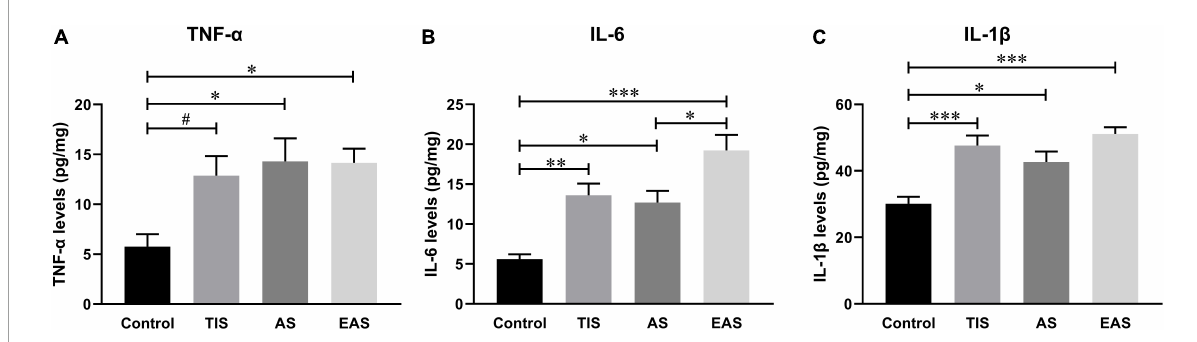
FIGURE8 Hippocampal inflammatory cytokine levels on postoperative day 1. (A) Compared with controls, TNF- α levels significantly increased in abdominal and extended abdominal surgical mice on postoperative day 1. (B) IL-6 levels significantly increased on postoperative day 1 after each type of surgery, with a higher level after extended abdominal surgery than that after abdominal surgical mice. (C) IL-1 β levels were also significantly increased after all three types of surgery, however, with no significant differences among groups. Data represent mean ± SEM ( n = 6). # P < 0.1; ∗ P < 0.05; ∗∗ P < 0.01; ∗∗∗ P <